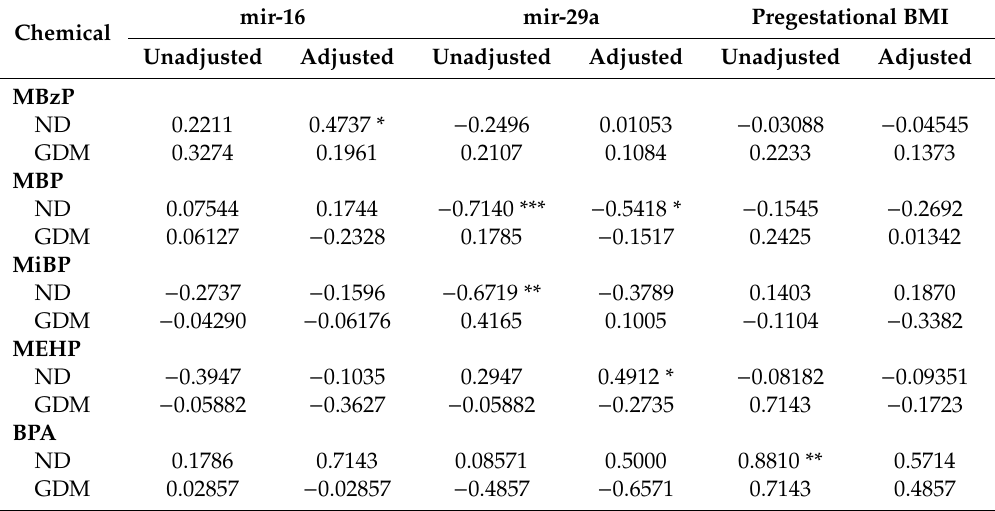
Table 4. Spearman correlation coe ffi cients between unadjusted ( µ g / L) and adjusted ( µ g / g Cr) urinary concentrations of total BPA and phthalates and relative expression of circulating miRNAs and Pregestational